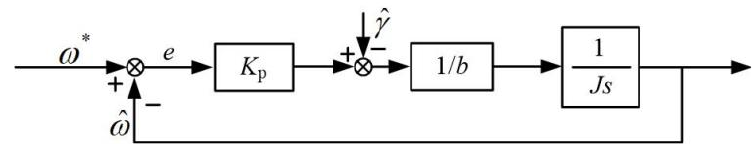
Figure 4. The equivalent block diagram of speed loop.